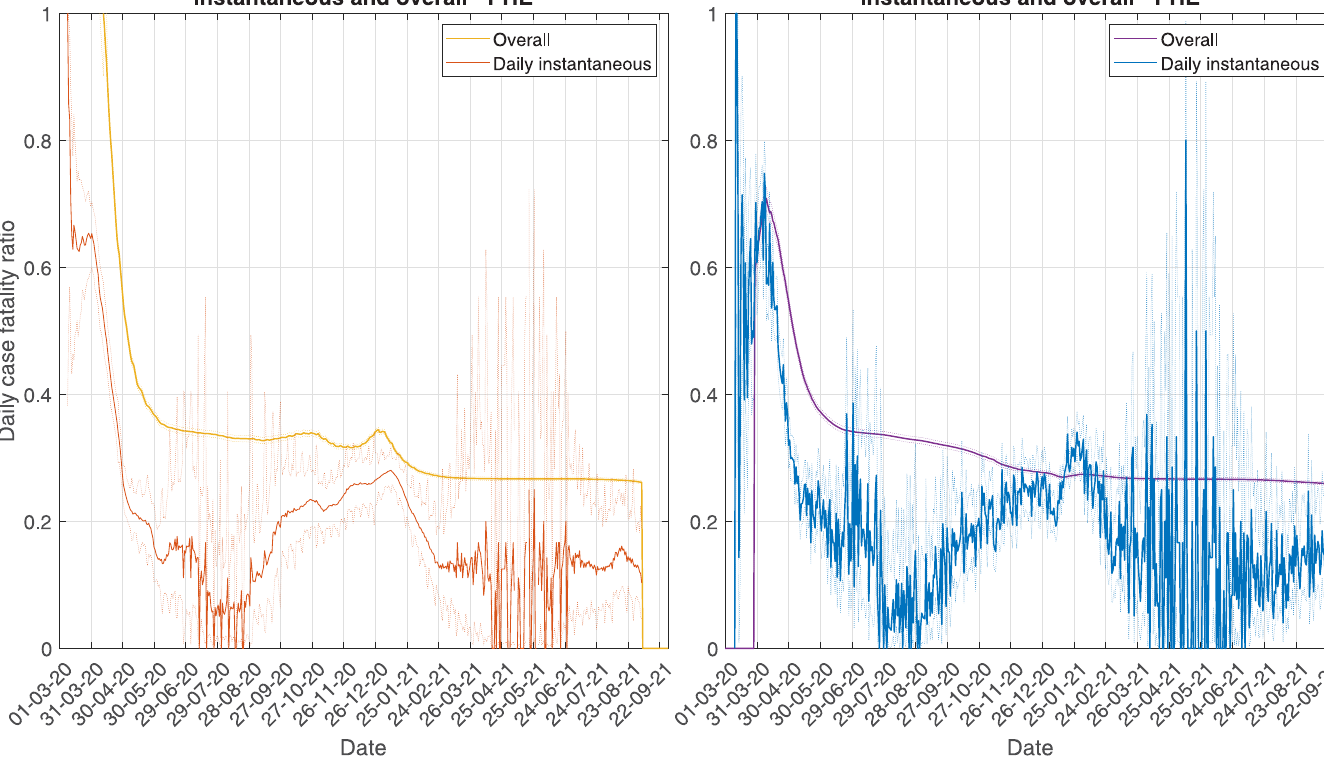
PLOS Computational Biology | https://doi.org/10.1371/journal.pcbi.1010554 October 24,